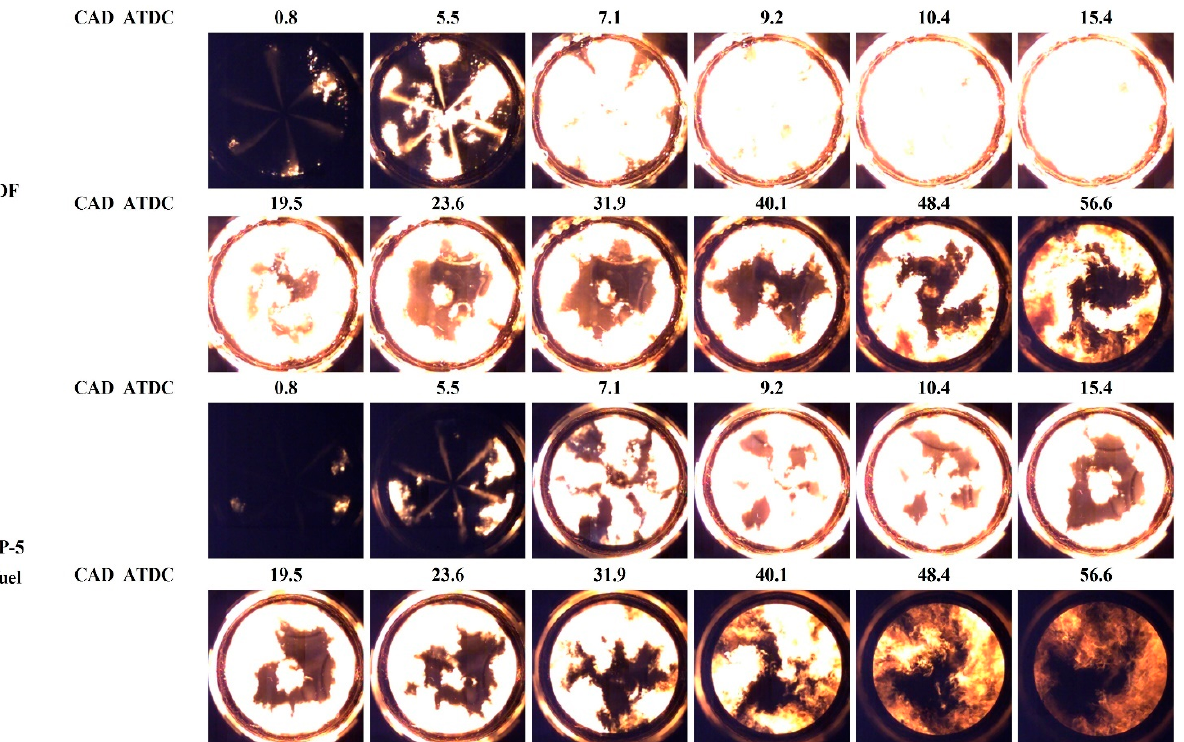
Figure 9. Combustion visualization of the DF and JP-5 fuels at the injection timing of BTDC 6 CA .